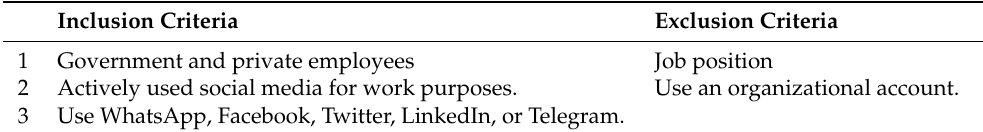
Table 1. Inclusion and exclusion